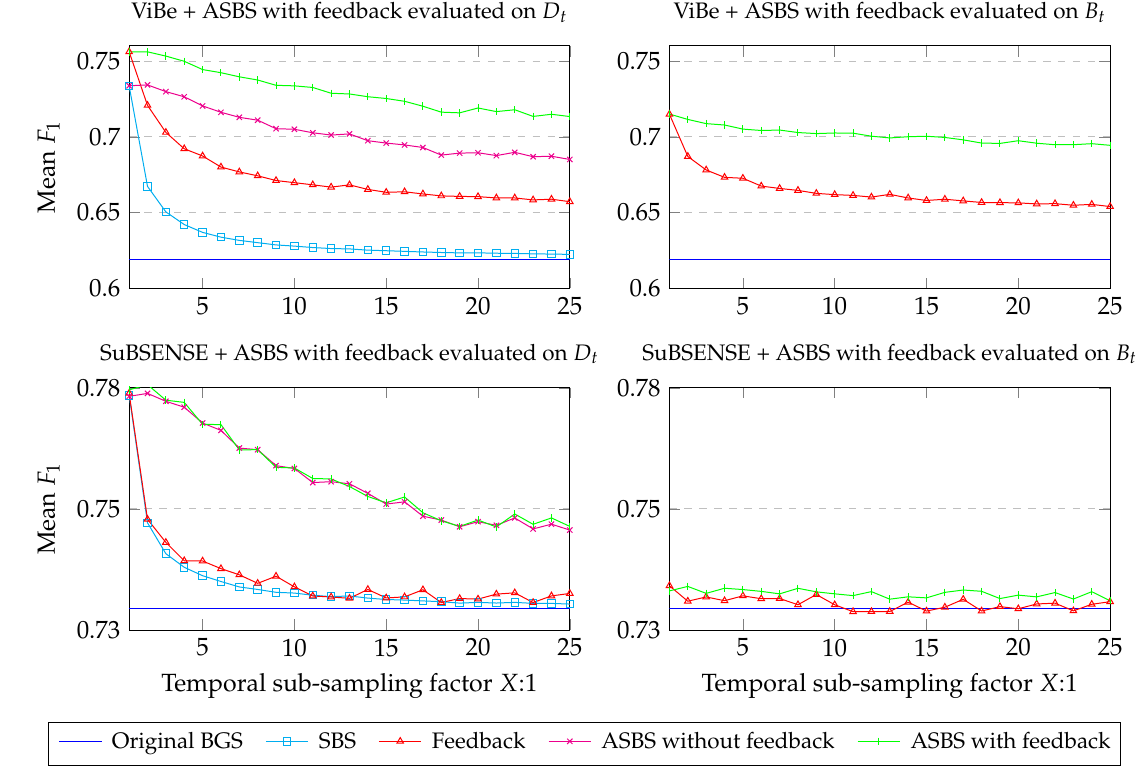
Figure 9. Comparison of the performances, computed with the mean F 1 score on the CDNet 2014, of SBS and ASBS when there is a feedback that uses D t to update the model of the BGS algorithm. The results are given with respect to a decreasing semantic frame rate. It can be seen that SBS and ASBS always improve the results of the original BGS algorithm and that a feedback is beneficial. Graphs in the right column show that the intrinsic quality of the BGS algorithms is improved, as their output B t , prior to any combination with semantics, produces higher mean F 1